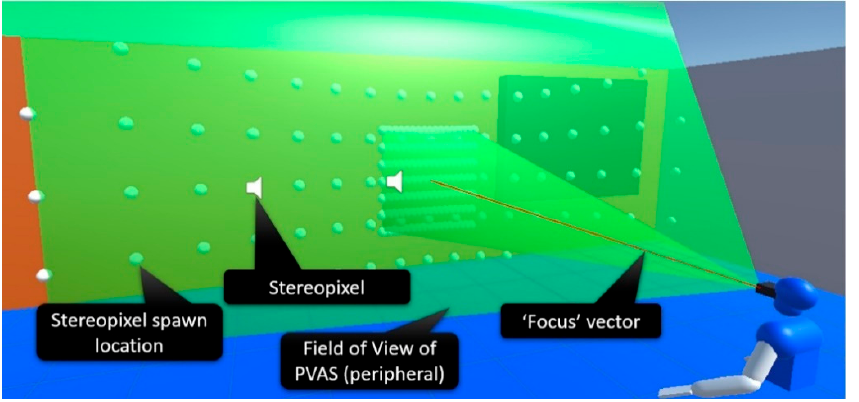
Figure 2. VES-PVAS sensory substitution